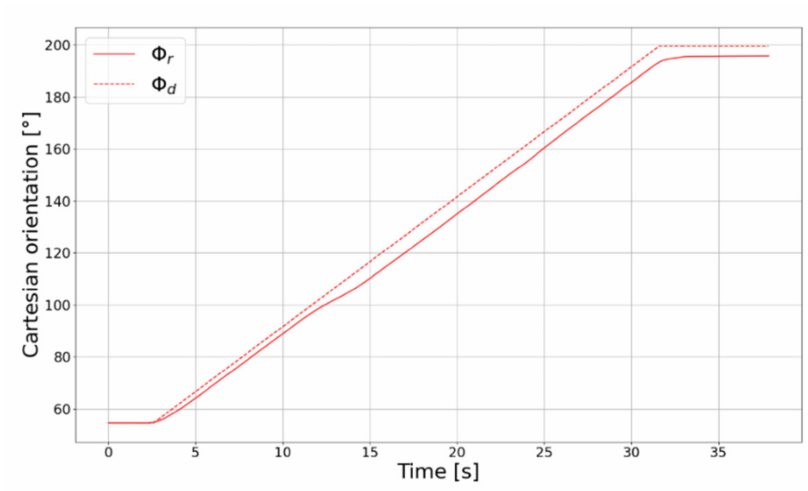
Figure 20. Comparison between the desired probe self-rotation φ d and the executed self-rotation φ r when applying the adaptive JLA strategy.